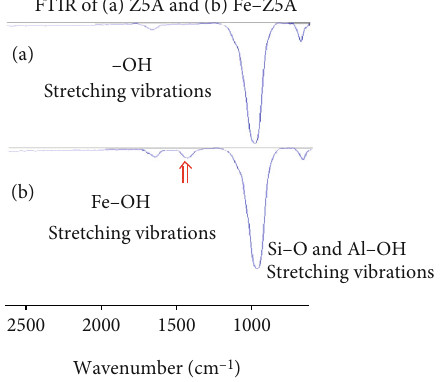
Figure 2: FTIR spectra of Z5A and Fe-Z5A.